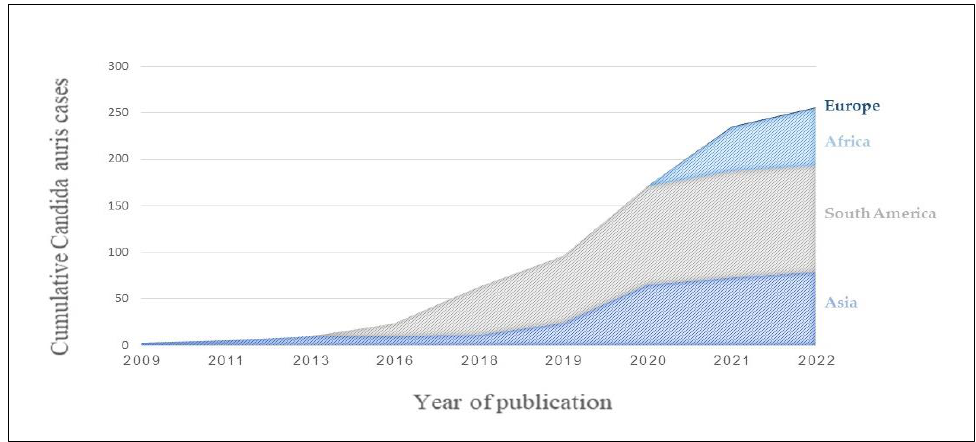
Figure 1. Confirmed cumulative C. auris incidences in children, by official year of publication.